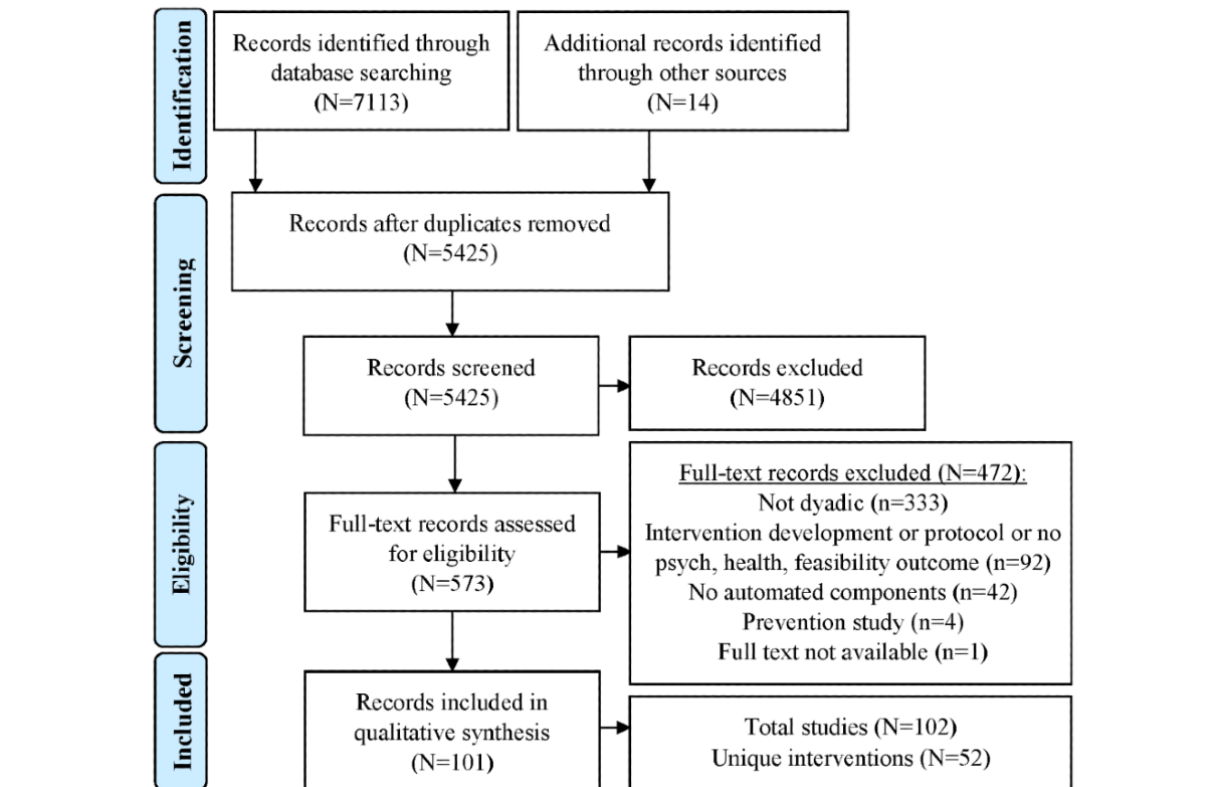
Figure 1. Preferred Reporting Items for Systematic Reviews and Meta-Analyses flow